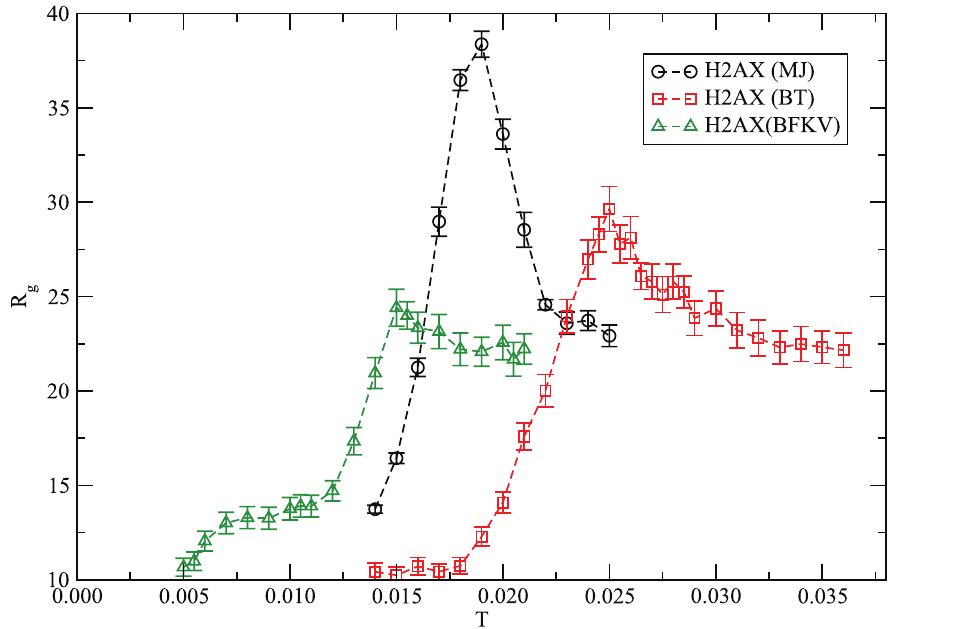
Figure 4. Variation of the average radius of gyration ( R g ) of histone H2AX with the temperature using MJ, BT and BFKV potentials. Simulations are performed for t=10 7 MCS time on a 64 3 lattice with 150 independent samples.